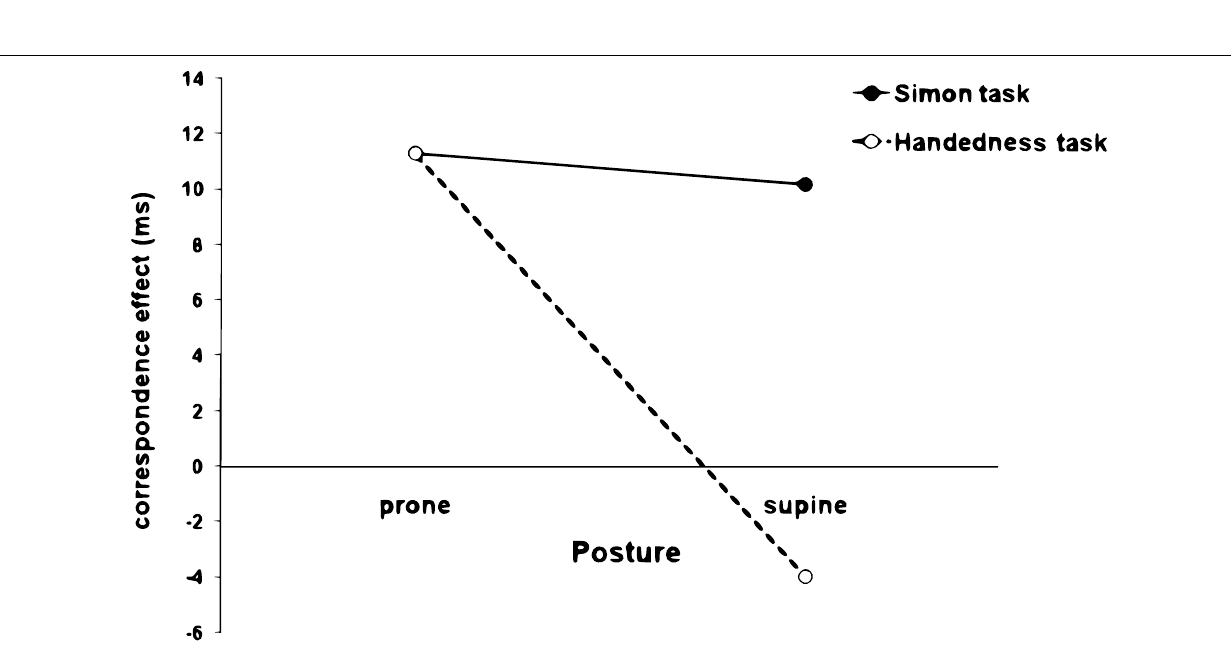
FIGURE 4 | Infl uence of hand posture on amplitude of the correspondence effect for each task. There is no difference between the correspondence effect amplitude in both postures in the regular Simon task. However, in the Handedness task, the amplitude of the correspondence effect in the prone posture is larger than in the supine